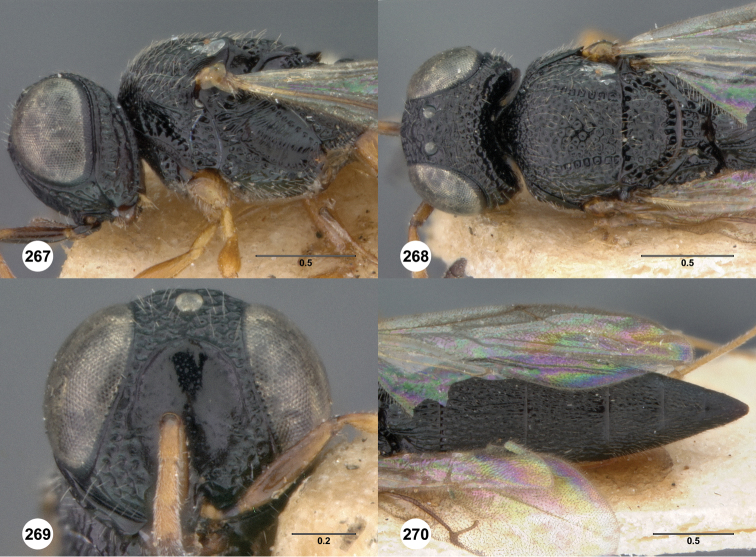
Oxyscelio productionis sp. n., holotype female (ANIC DB 32-020073) 267 Head and mesosoma, lateral view 268 Head and mesosoma, dorsal view 269 Head, anterior view 270 Metasoma, dorsal view. Morphbank79